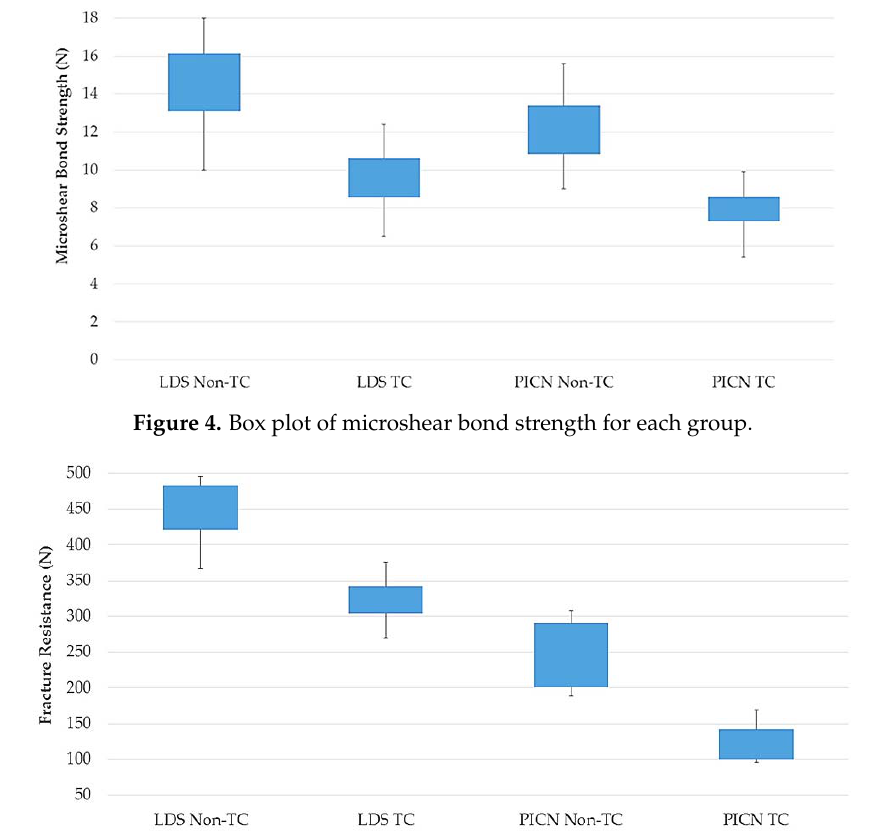
Figure 5. Box plot of fracture resistance for each group.